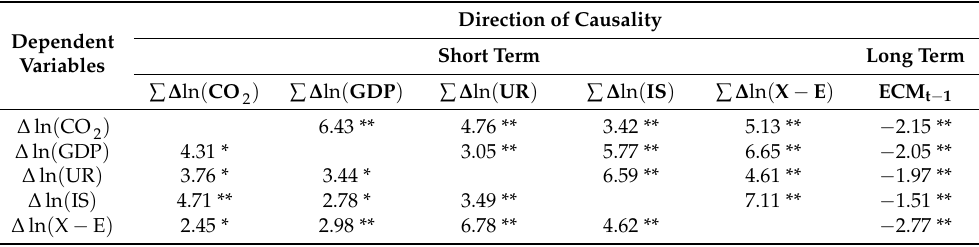
Table 3. The result of the VARIMAX-ECM